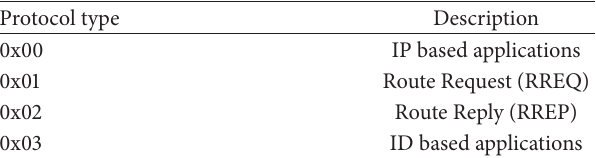
Table 1: Protocol types of IDHOCNET.